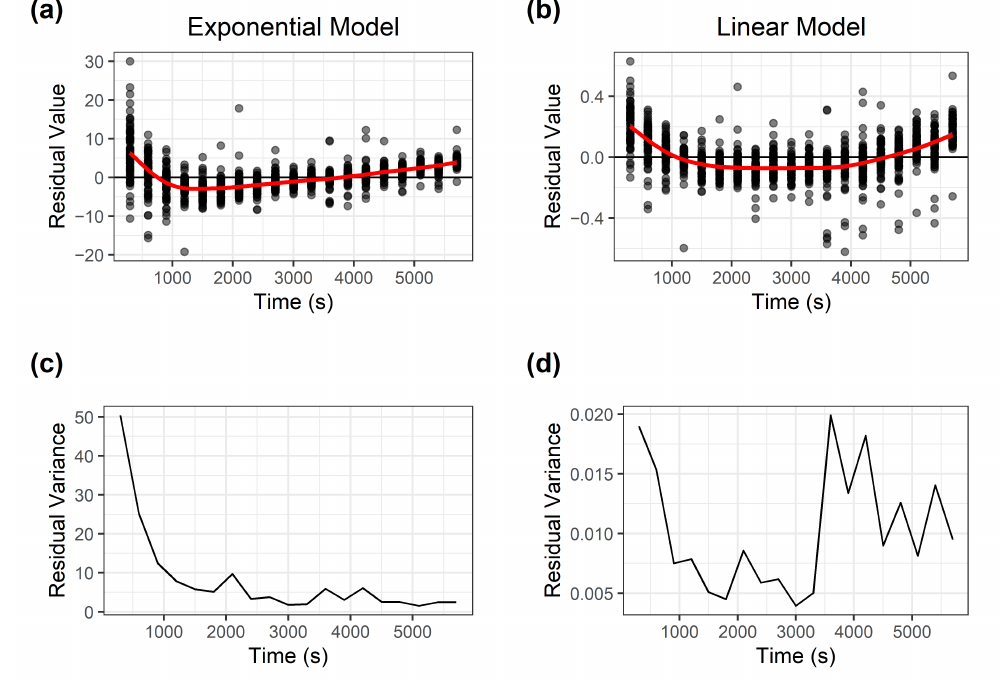
Figure A4. Plots of residuals and residual variance pooled from all 12 experimental treatments including controls. Red lines are locally-weighted smoothing functions ( a ) Residuals of the exponen- tial model. ( b ) Residuals of the log-transformed linear model used in analyses. ( c ) Variance of the residual values of the exponential model. ( d ) Variance of the residual values of the log-transformed linear model used in